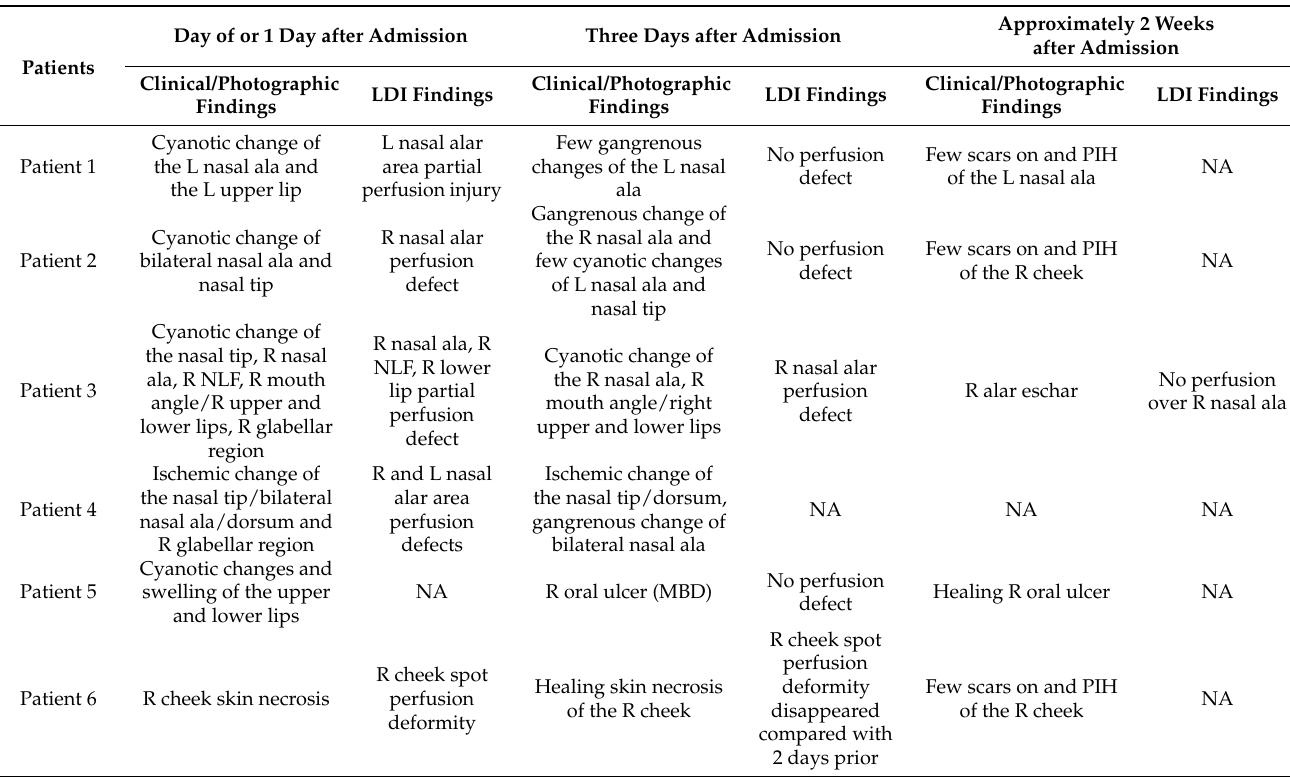
Table 2. Clinical examination, photography, and patients’ LDI findings on days 0, 3 and 14 of admission.